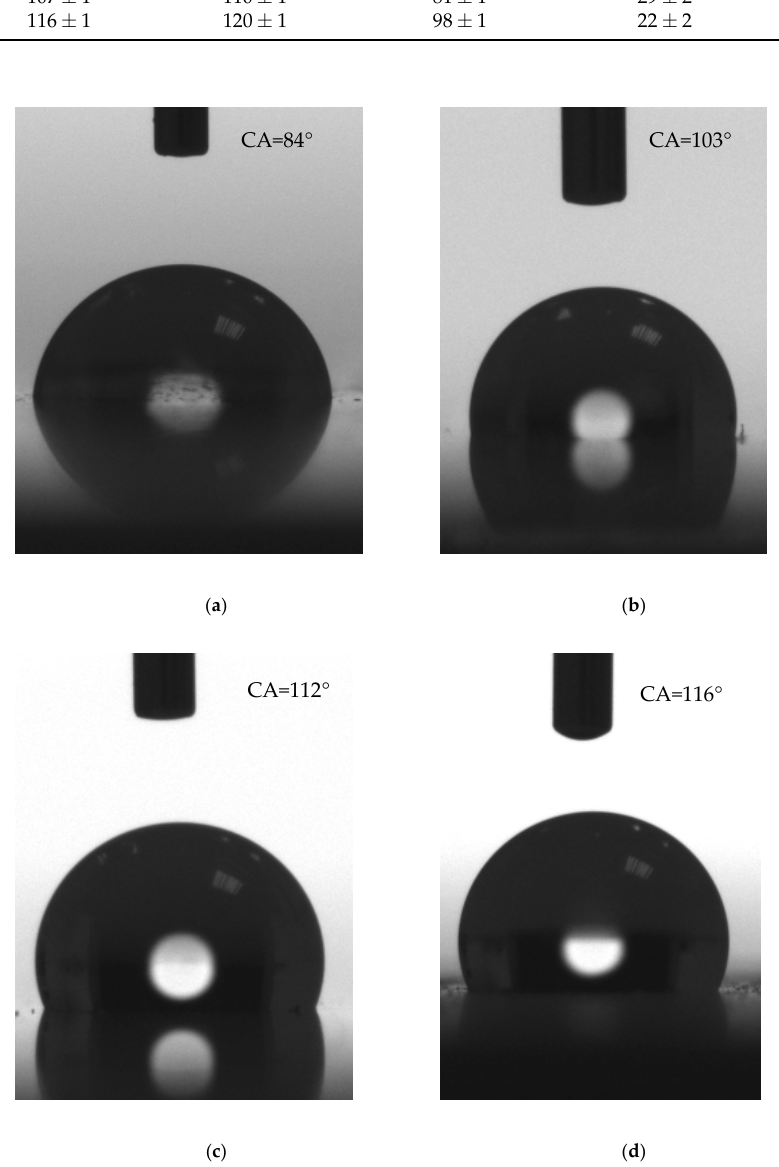
Figure 4. Images of wettability contact angle of the samples. ( a ) reference; ( b ) SiO 2 ; ( c ) SiO 2 + DC88; ( d ) SiO 2 +